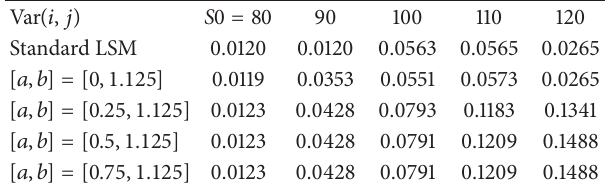
Table 5: Numerical result for Example 5.